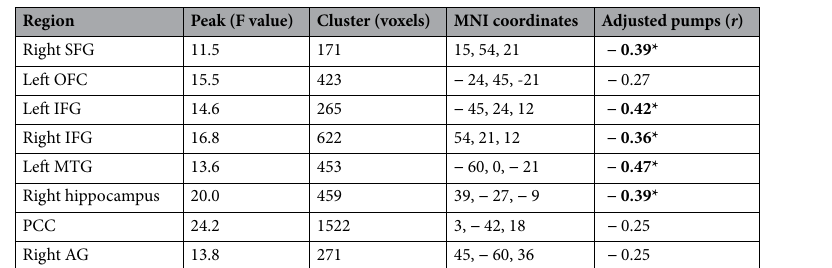
Table 2. The putamen network was changed and correlated to risk behaviors across groups. Significant group differences in the putamen network were examined using ANCOVA, controlled for education, head motion, and brain atrophy ( p < 0.05, GRF correction). Partial correlation was applied to examine the relationships between connectivity strength and adjusted pumps in the BART, controlled for education, head motion, and brain atrophy (FDR corrected p < 0.05 for multiple comparison). Abbreviations: AG, angular gyrus; MNI, Montreal Neurological Institute; IFG, inferior frontal gyrus; MTG, middle temporal gyrus; OFC, orbital frontal cortex; PCC, post cingulate cortex; SFG, superior frontal gyrus. Significant values are in [bold].